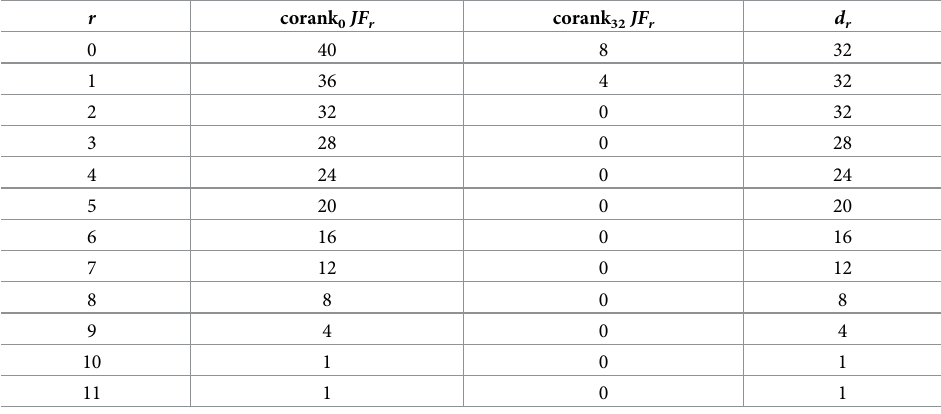
Table 10. Summary of computations showing 1 dimension of unidentifiability. r corank 0 JF